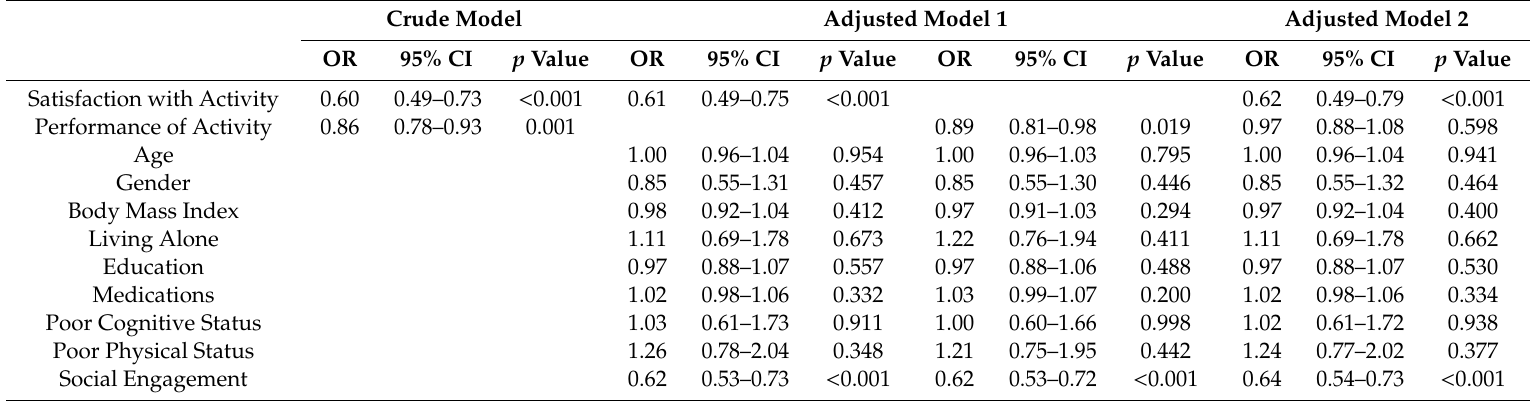
Table 2. Association between depressive symptoms, satisfaction, and